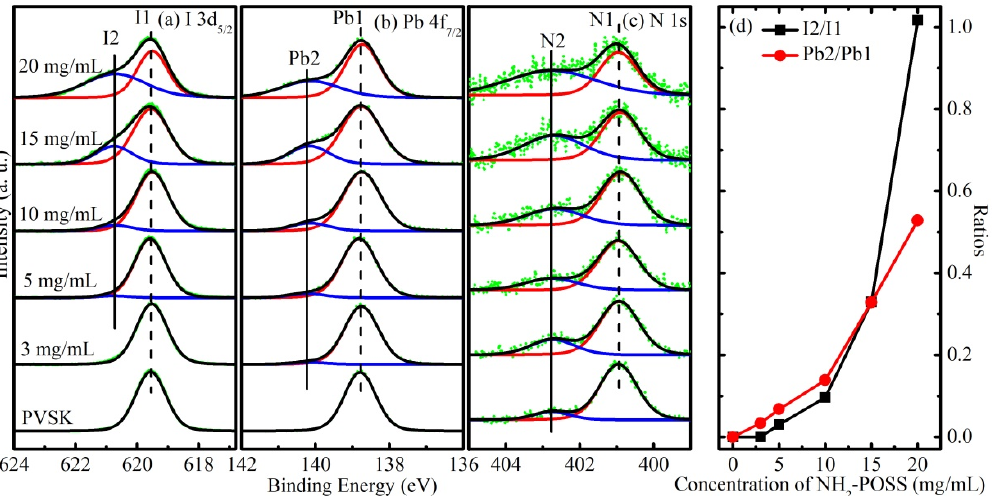
Figure 2. XPS spectra of ( a ) I 3d 5/2 , ( b ) Pb 4f 7/2 , and ( c ) N 1s for perovskite films fabricated with different concentrations of NH 2 -POSS. ( d ) The ratio of I2/I1 and Pb2/Pb1 with different concentrations of NH 2 -POSS.